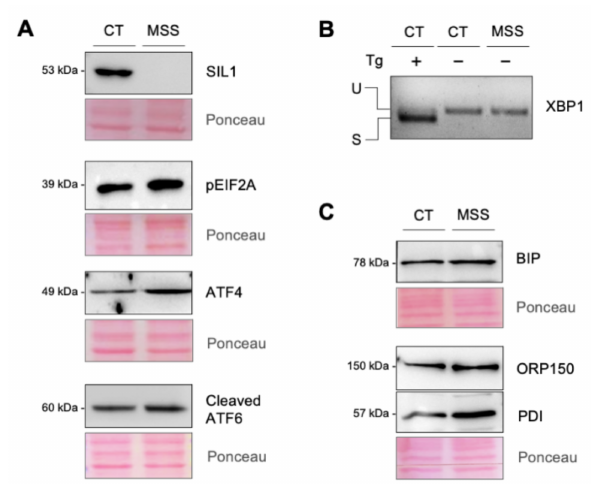
Figure 1. UPR activation in MSS patient fibroblasts. ( A , C ) HF-CT (CT) and HF-MSS (MSS) cultured under standard growth conditions were analyzed by Western blotting to assess the expression of SIL1, ATF4, ATF6, and the phosphorylated form of EIF2 α ( A ), BiP, ORP150, and PDI ( C ) as indicated. Immunoblots are representative of at least two independent experiments. Ponceau S staining of the blots is shown to control for equal protein loading. ( B ) XBP1 splicing was assessed by PCR. HF-CT (first lane) treated with 1 µ M thapsigargin (Tg) for 6 h was used as a positive control. The higher and lower bands represent the unspliced (U) and spliced (S) forms of